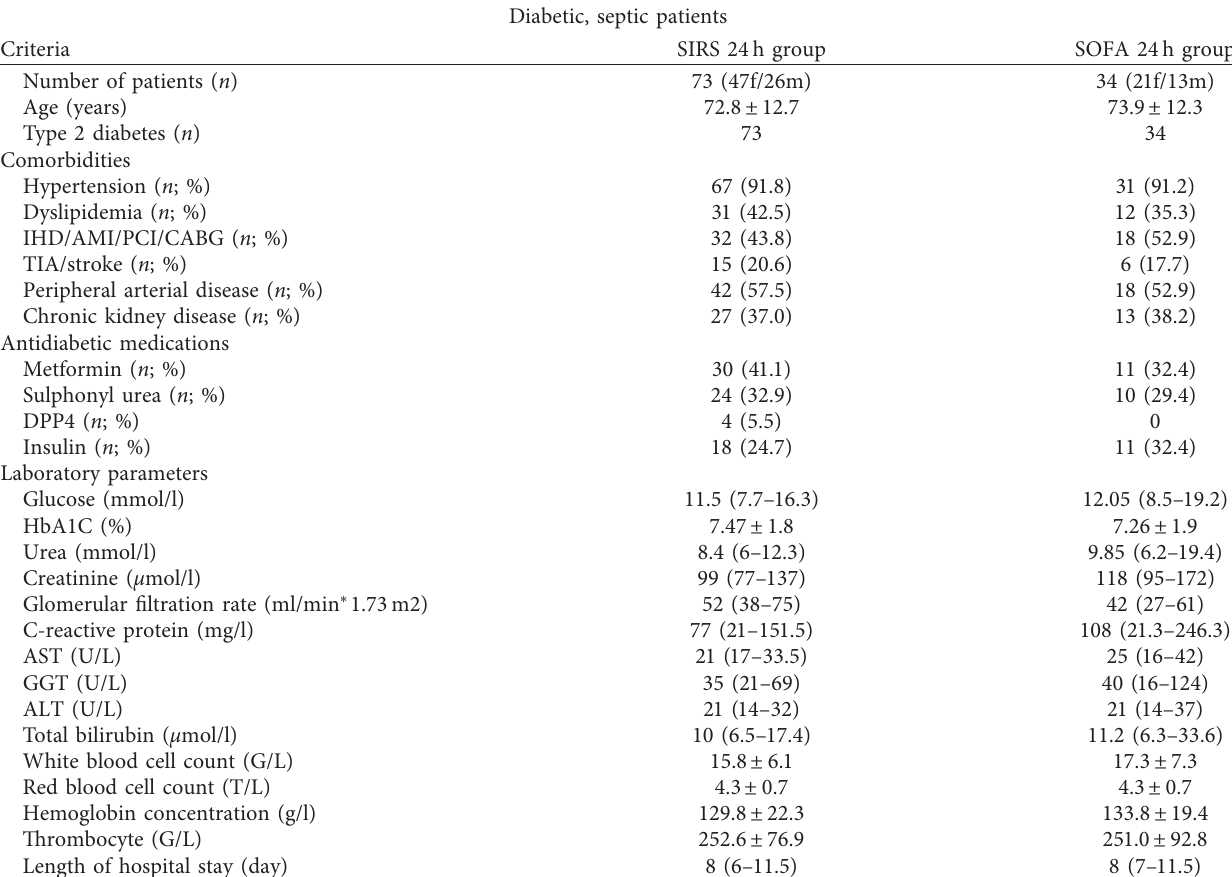
Table 1: Anthropometric data, antidiabetic therapy, and laboratory parameters of diabetic, SIRS 24h, and SOFA 24h septic patients.